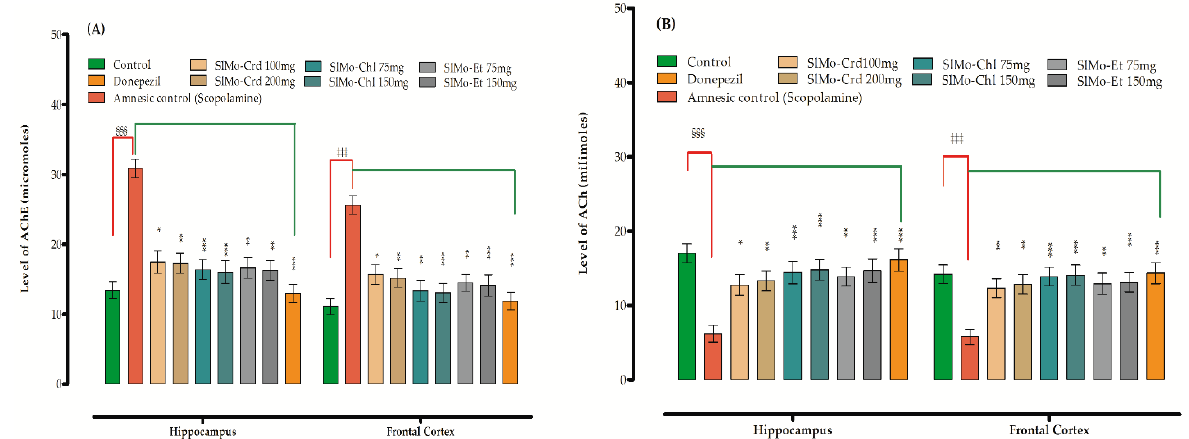
Figure 3. Effect of SlMo-Crd and fractions on ( A ) AChE and ( B ) ACh level in brain. Mean ± SEM ( n = 6). Oneway ANOVA followed by Dunnett’s post hoc multiple comparison test have been used to estimate the values of p ; §§§ p < 0 001, ‡‡‡ p < 0 001 has been used for comparison of scopolamine- treated (amnesic) group vs normal control group, * p < 0.05, ** p < 0.01 and *** p < 0.001 compare the scopolamine-treated (amnesic) group vs Donepezil, crude extract and fractions-treated groups.